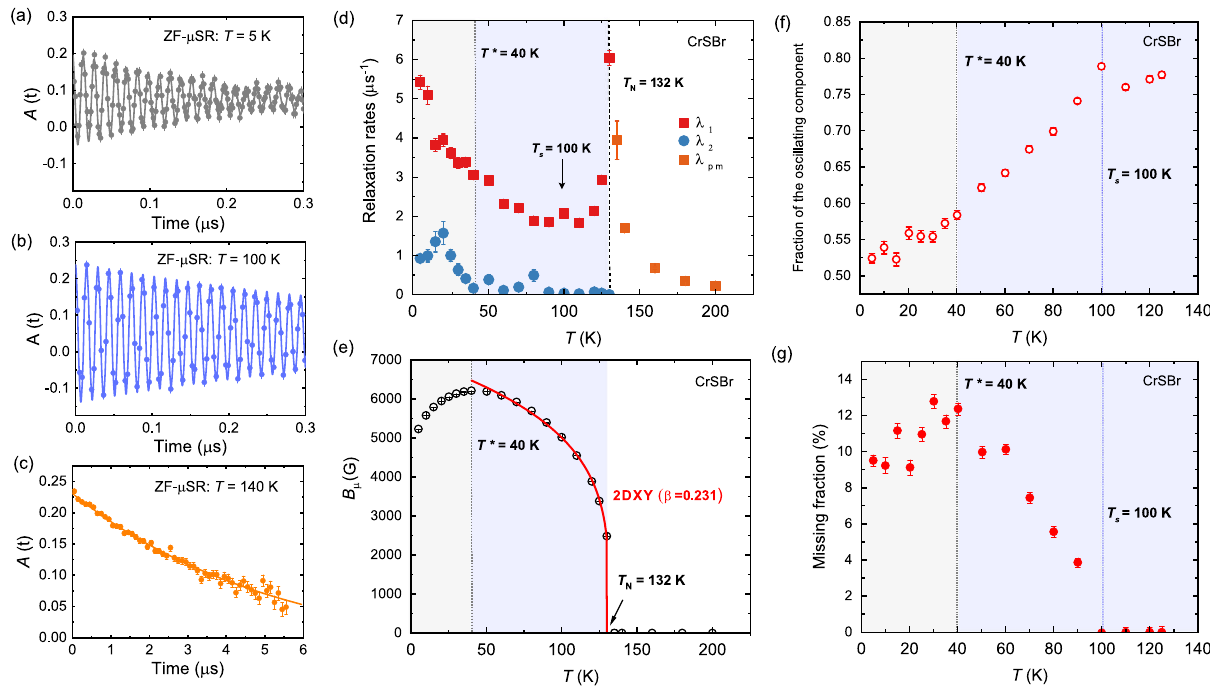
Fig.6|ZF- μ SRmeasurementsonCrSBr.a – c ZF- μ SRspectraforCrSBratdifferent temperatures. Lines show fi tting to Eqs. (3) and (4) (see Supplementary Note 4). Error bars in the μ SR asymmetry are derived from the standard error of each bin over about ~10 6 events. d Temperature dependence of the muon spin relaxation rates λ pm (orange squares), λ 1 (red squares) and λ 2 (blue circles). e Temperature